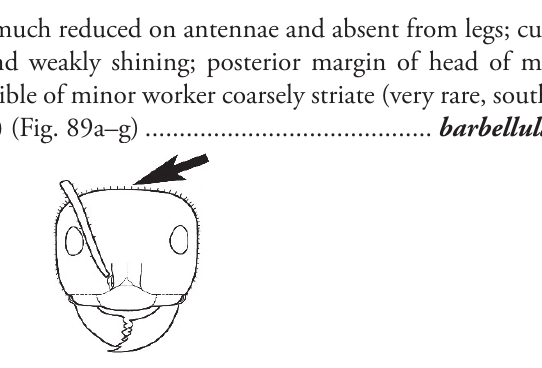
8 Maxillary palp segments short (not reaching neck sclerite), narrow and terminating in a subulate (awl-shaped) segment; PF 6,4; metatibial apical spur absent; in full-face view, masticatory margin of mandible strongly oblique with four teeth in known major workers (except chrysus ), and four to six teeth in minor worker ( M . anderseni species-group) ............................... 9